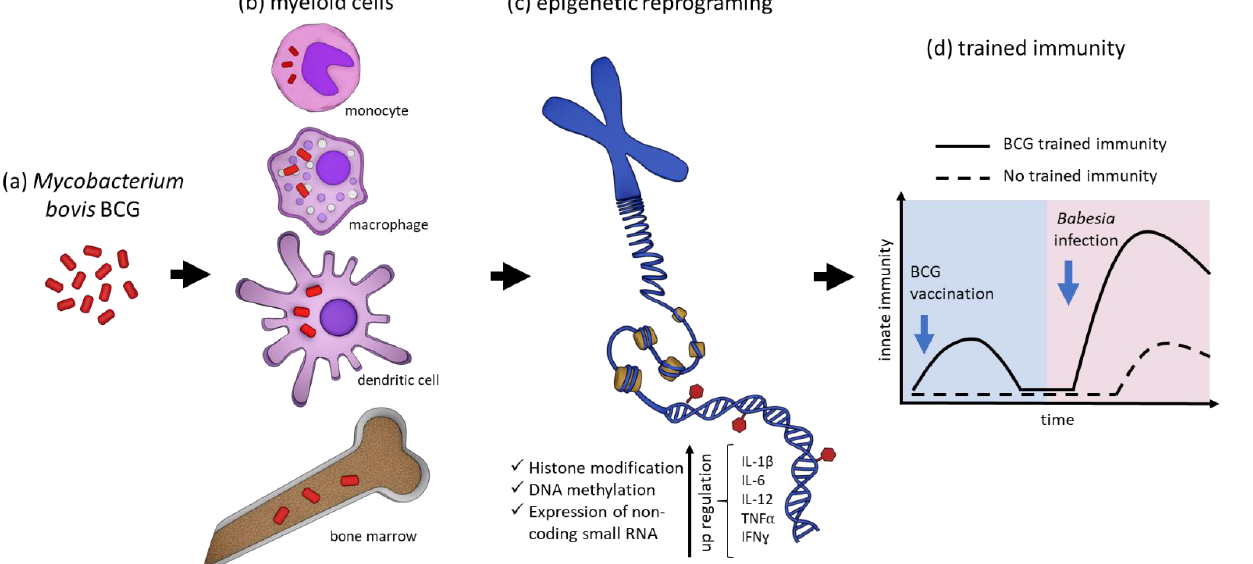
Figure 1. Trained immunity (TI) induced by Mycobacterium bovis BCG and its implication on Babesia infection. ( a ) Upon inoculation, BCG is phagocytosed by ( b ) myeloid cells, primarily monocytes, macrophages, and dendritic cells (DC), and myeloid precursor cells in the bone marrow. ( c ) BCG can survive inside the cells and induce TI by epigenetic reprograming mechanisms, which are char- acterized by histone modifications, DNA methylation in target genes, and expression of non-coding small RNA. ( d ) We hypothesize that epigenetic reprograming would allow these innate immune cells to respond faster and more efficiently to Babesia infection, which in turn, will elicit protection against acute babesiosis. Table 1. BCG trained immunity and its potential effects on Babesia